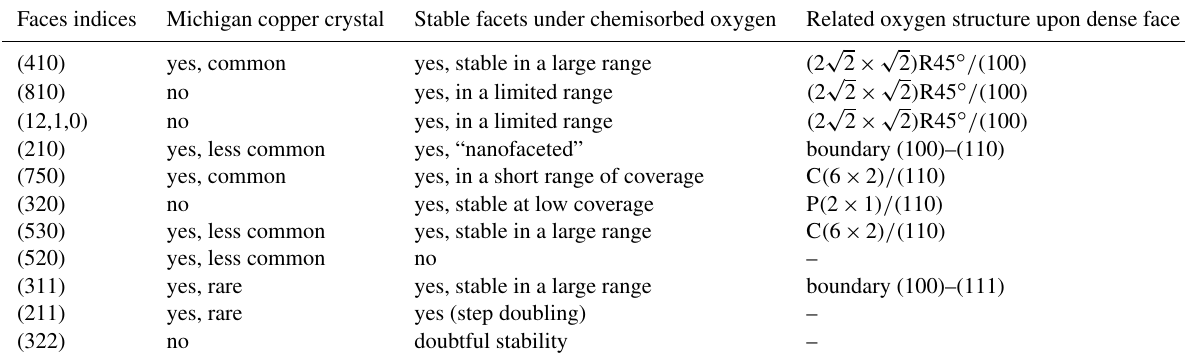
Table 1. Stable faces of Michigan copper crystals and stable high indices faces or facets under oxygen adsorption. Faces indices Michigan copper